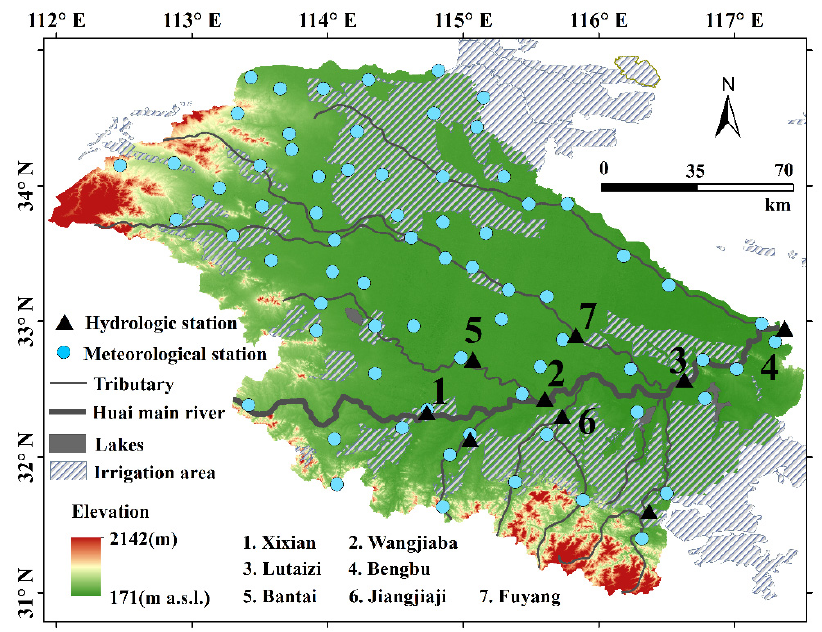
Figure 1. Locations of the hydrological and meteorological stations in the HRB. Table 1. Locations of the hydrological stations considered in this study and related geographical features. River